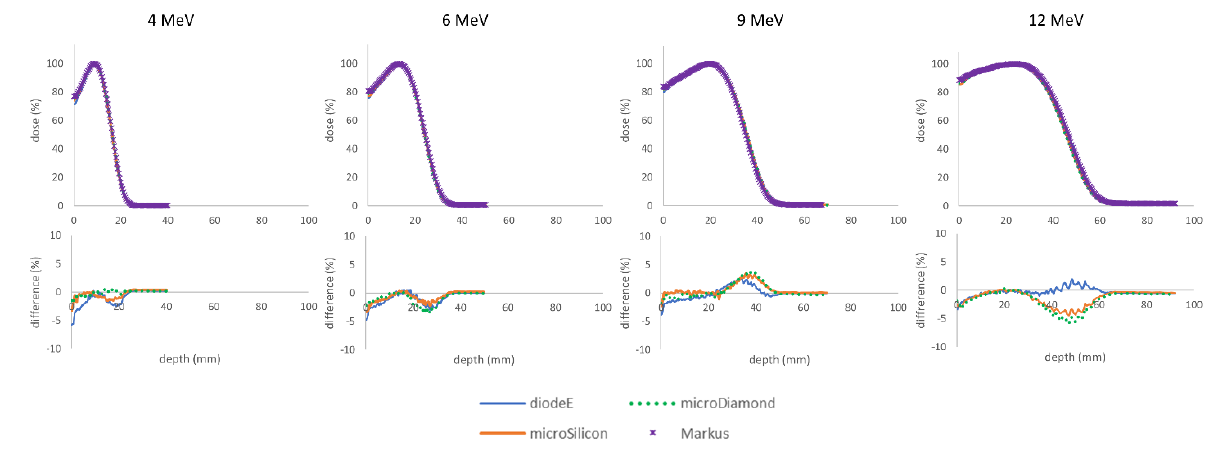
Figure 1. In the upper part: PDD curves measured with the three solid-state detectors and the plane-parallel ionization chamber for the 50 mm diameter field; the percentage doses are relative to the peak of the PDD curve. In the bottom part: % differences between PDDs, measured by the solid-state dosimeters and the ionization chamber. Table 1. Maximum difference in distance (mm), within the 20-80% PDD region for the solid-state detectors (diode E reported as d-E, microDiamond as m-D and microSilicon as m-Si), with respect to the chosen reference for each beam energy. The mean value over all beam energies was also